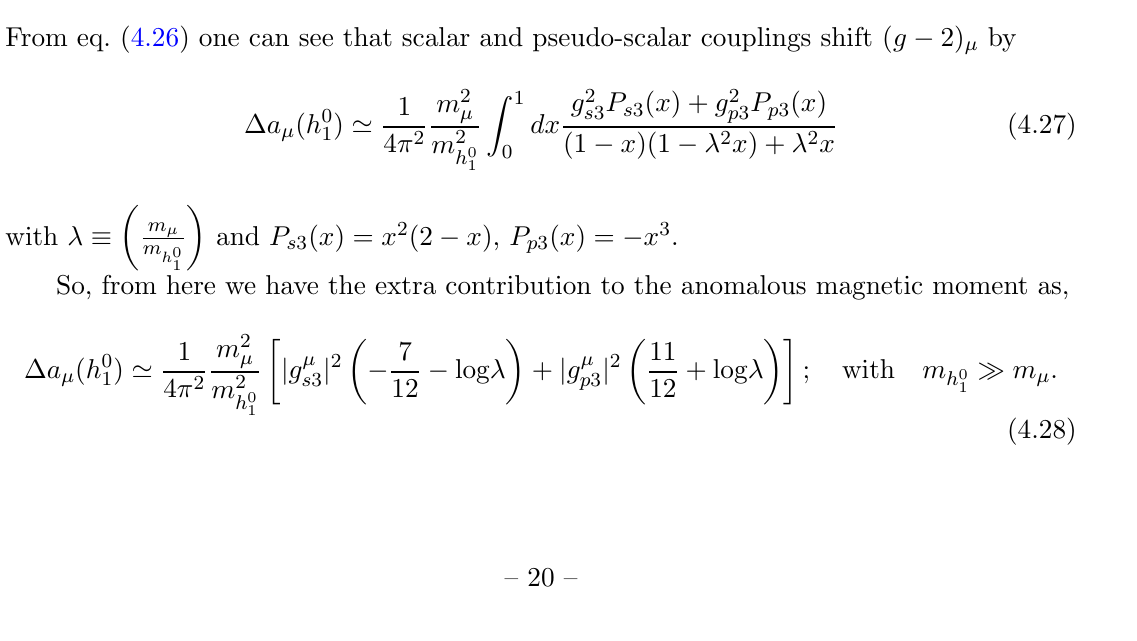
; h 0 with muons. 1 2